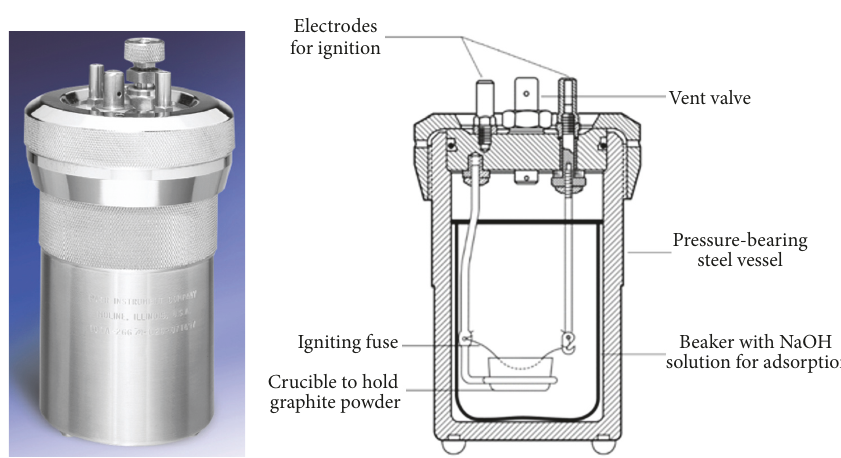
Figure 6: The oxygen combustion apparatus and structure